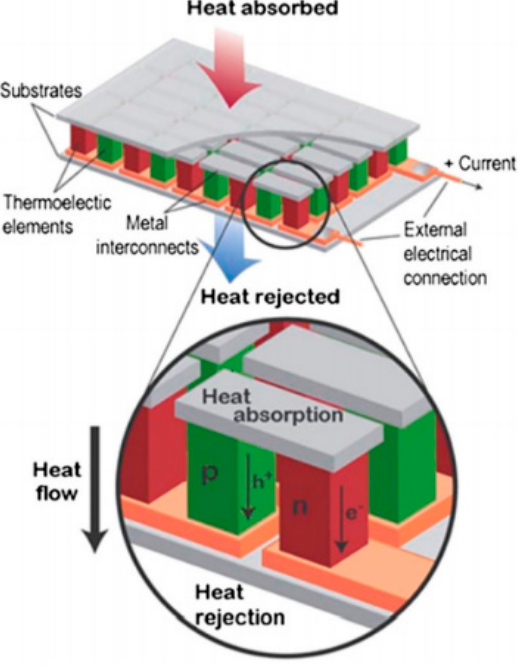
Figure 2. Diagram of a typical thermoelectric device [40].